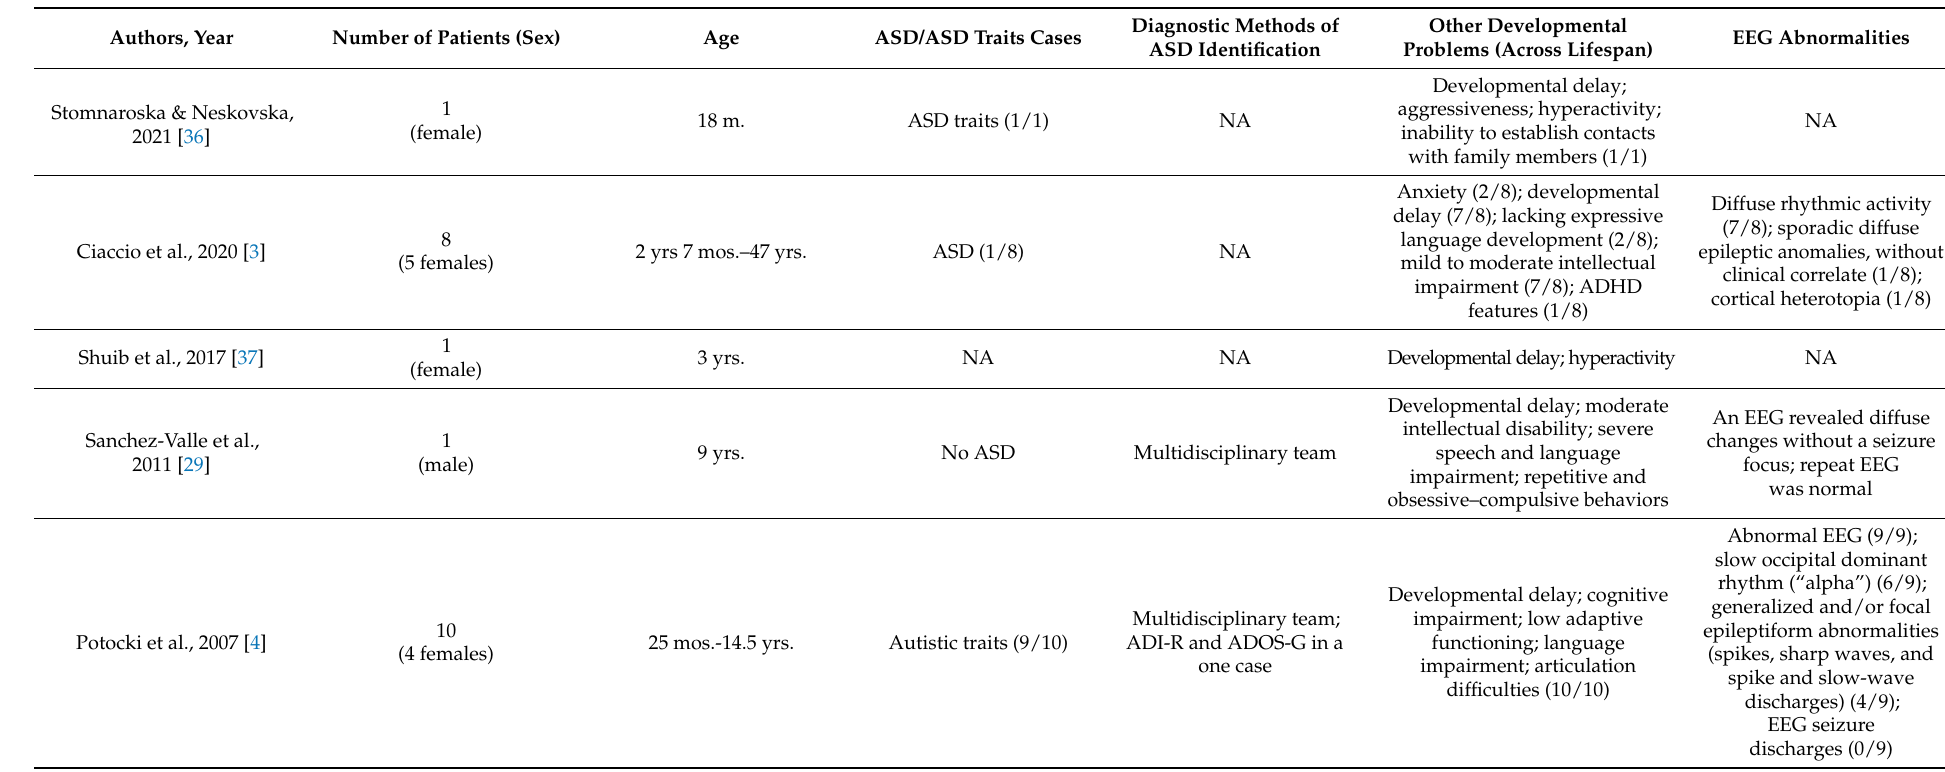
Table A1. Summary characteristics of the reported patients with Potocki–Lupski